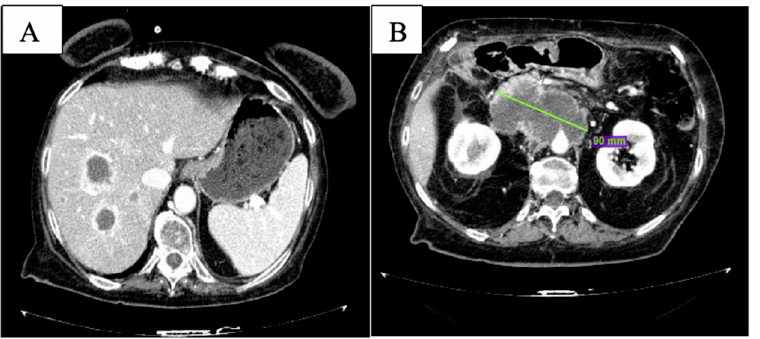
Figure 4. CT scan after 6 months of olaparib: new liver lesions are documented ( A ) and peripancreatic tissue is increased ( B ).